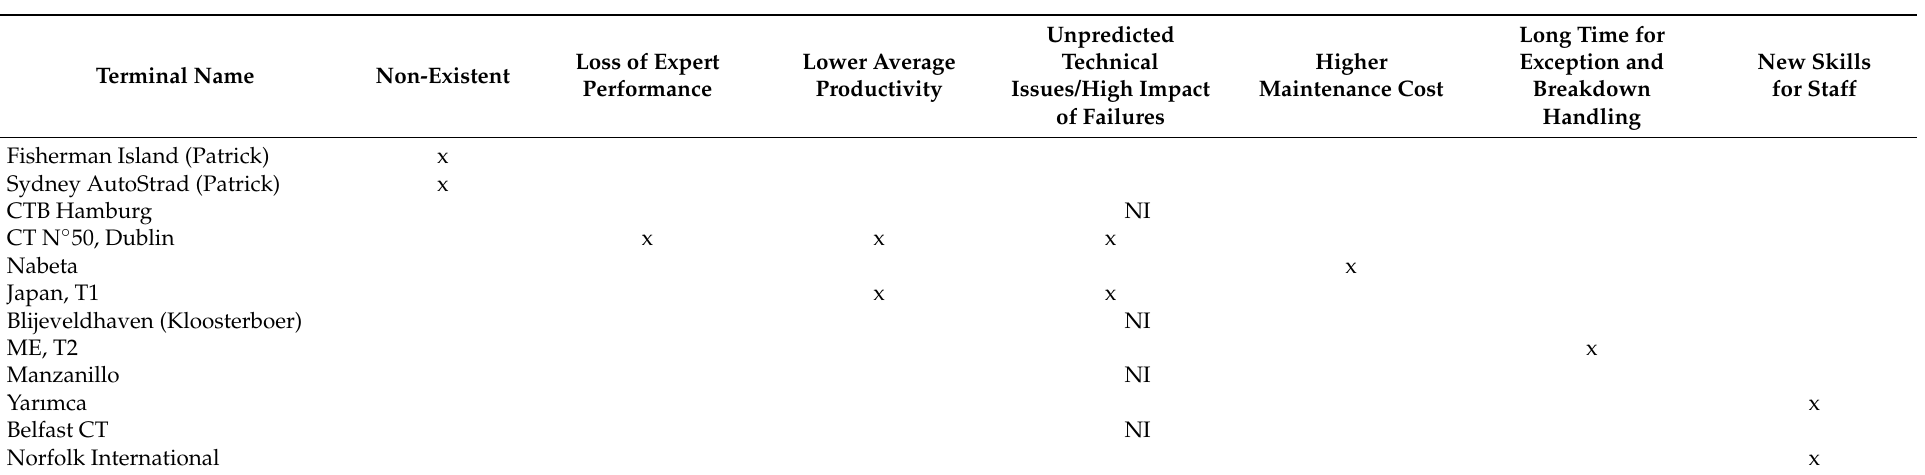
Table A6. Drawbacks from automation identified from questionnaire